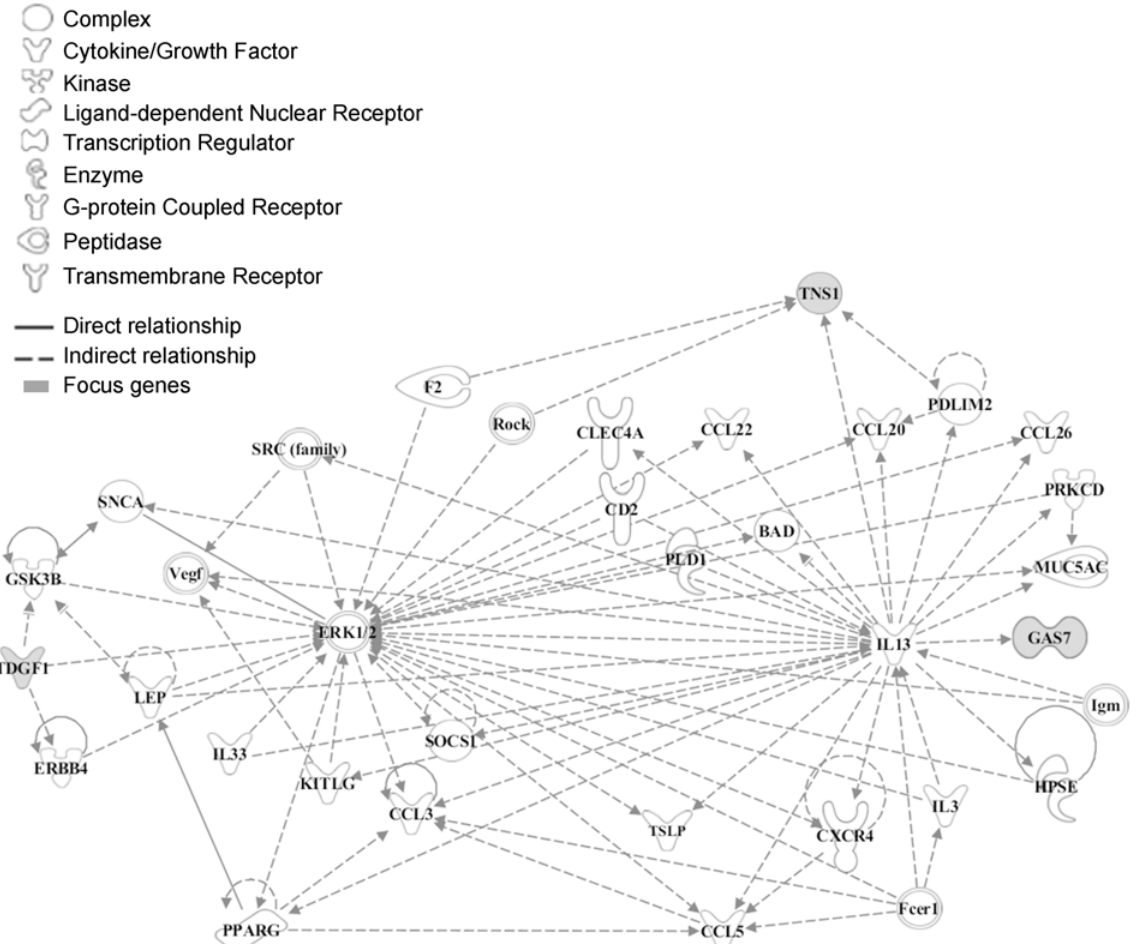
Fig 2. Functional analysis of the associated genes. The network was algorithmically constructed by Ingenuity Pathway Analysis (IPA) software on the basis of the functional and biological connectivity of genes. The network highlights the interconnections of 3 loci (marked in grey) identified from serum CRIPTO levels GWAS with a p-value = 1 * 10 – 6 . CRIPTO gene is reported as TDGF1 . Lines between genes represent known interactions and the nodes are displayed using various shapes that represent the functional class of the gene product